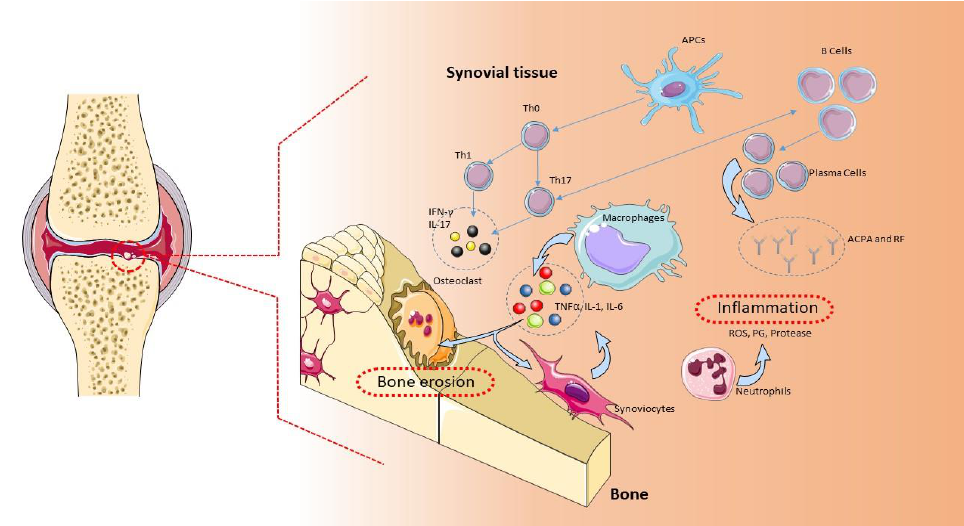
Figure 1. Pathogenic role of immune cells in rheumatoid arthritis (RA). The immune cells mainly involved in the pathogenesis of RA are B cells, T cells, and macrophages. These cells are normally present in the synovial tissue. B cells release proteins, such as rheumatoid factor (RF), protein antibodies (ACPAs), and proinflammatory cytokines, that support the establishment of RA. B cells also mediate the activation of T lymphocytes through the expression of costimulatory molecules. In RA, the main function of T lymphocytes is to activate macrophages. Activated T lymphocytes and macrophages release proinflammatory molecules, such as cytokines and chemokines, which keep the osteoarticular tissue inflamed. This condition favors the activation of synoviocytes and osteoclasts, with consequent damage to the osteoarticular tissue and pannus formation [1]. APCs: antigen-presenting cells, ROS: reactive oxygen species.